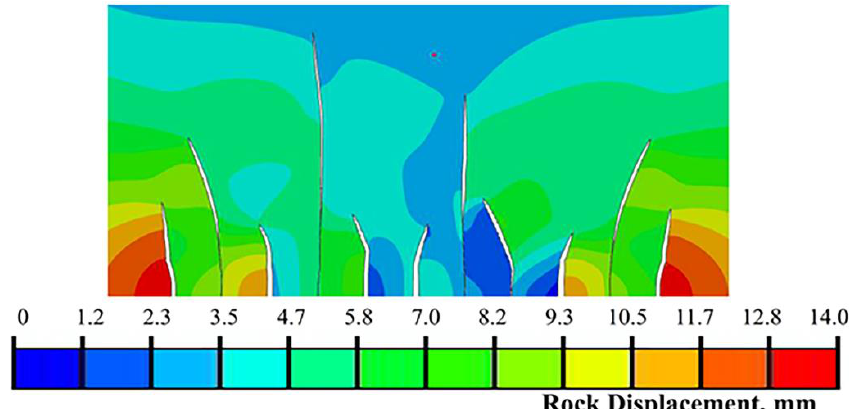
Figure 2. Schematic illustration of the influence of stress shadow on the dynamic propagation of hydraulic fractures.